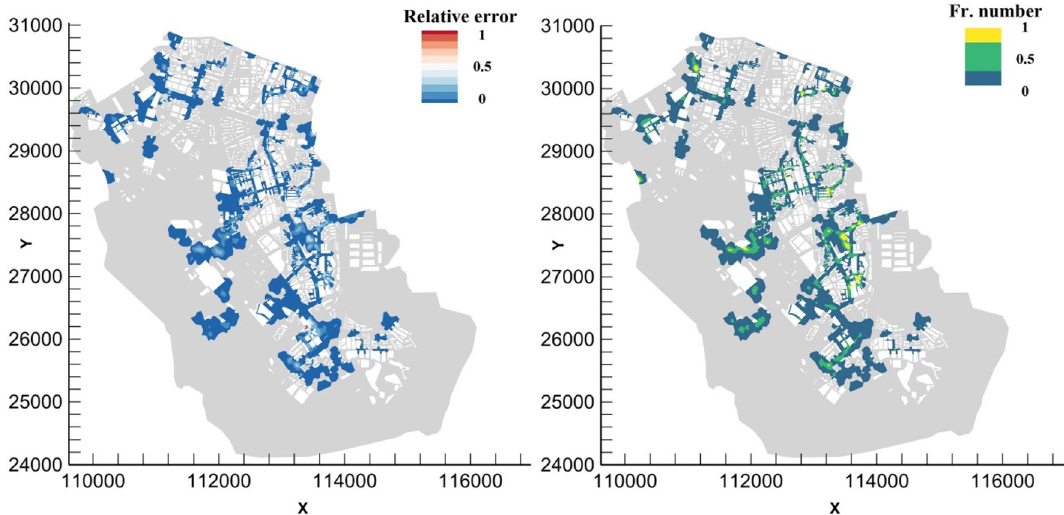
Fig. 16 Comparison of the relative errors of the maximum water depth (left) and Froude number distribution (right) Table 6 Average relative error (RE) and the proportion of the RE greater than 10% under different flow regimes Froude Number Average RE Proportion of RE [ 10% Fr \ 0.5 9.74%